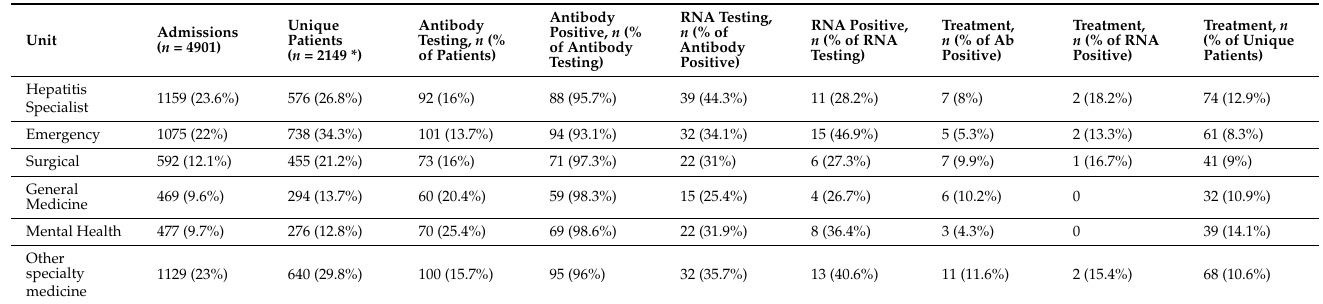
Table 2. The hepatitis C care cascade by specialty.